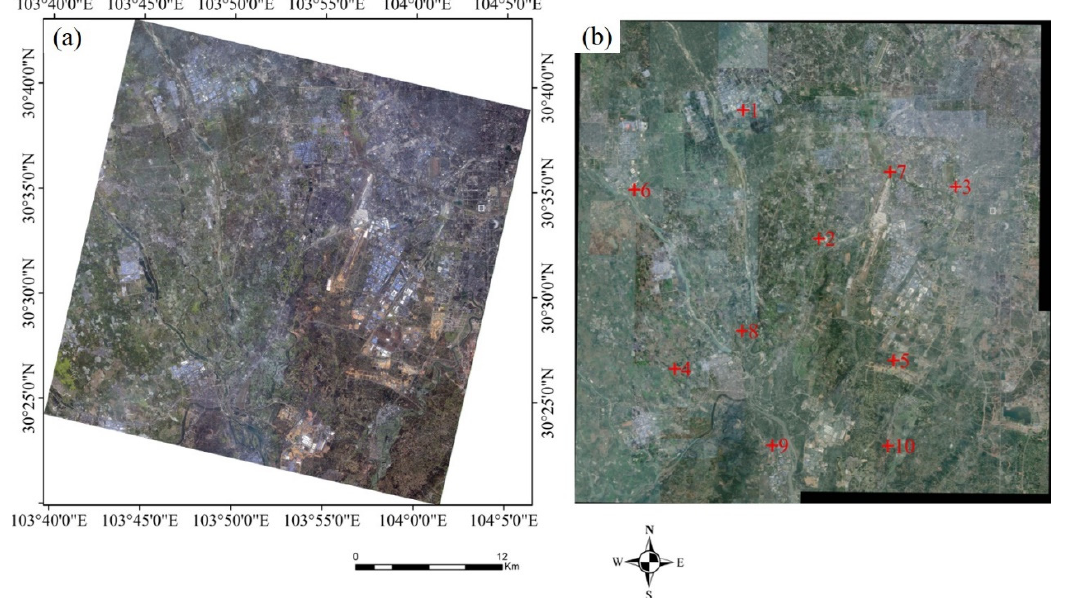
Figure 4. GaoFen multispectral images of P-A. ( a ) GF-1 image (input image), ( b ) GE image (reference image). Points in red are verification points.